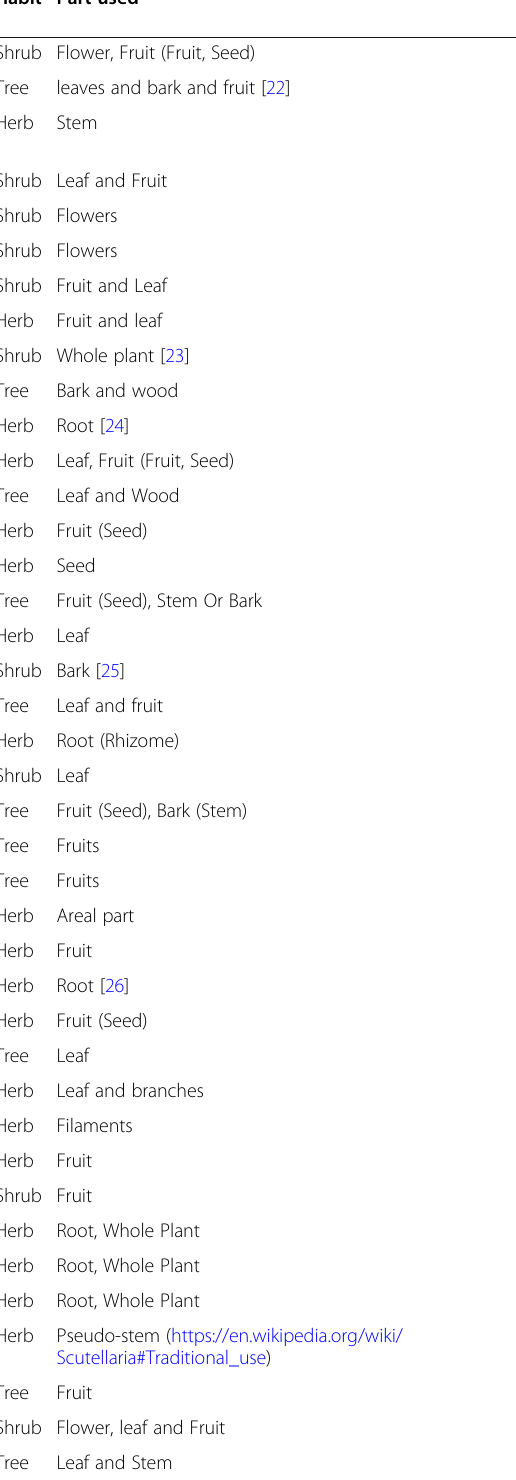
Table 1 List of plants, its habit and parts used for treatment of heart disease (Continued) S.